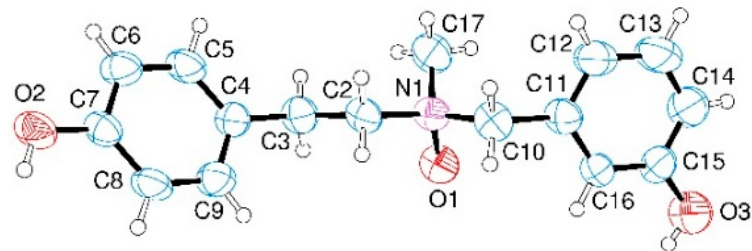
Figure 3. Crystal structure of 12b. Ellipsoids enclose 50% probability.